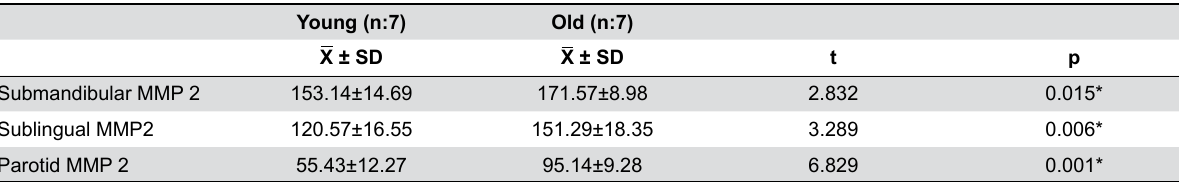
Table 1- Comparison of H-score values of young and old